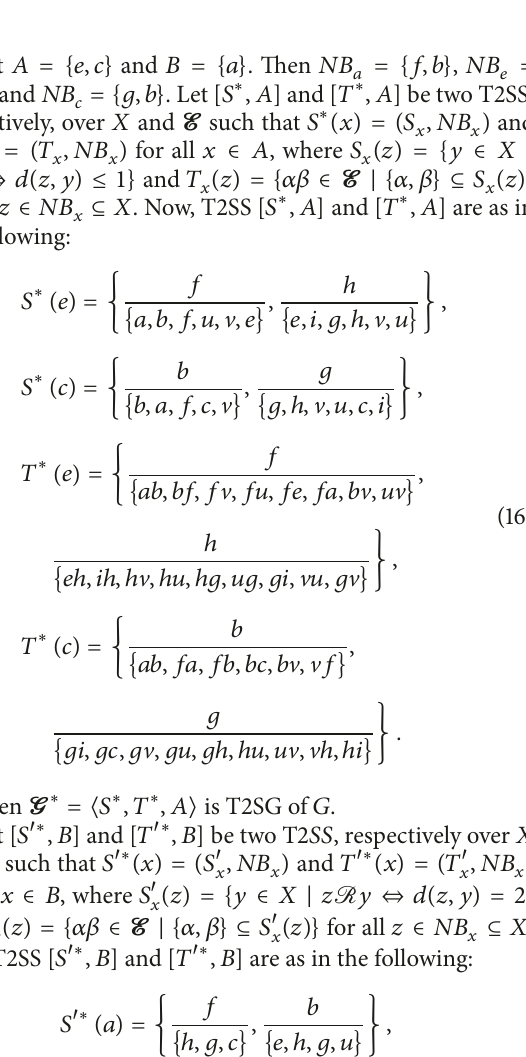
Figure 10: Simple